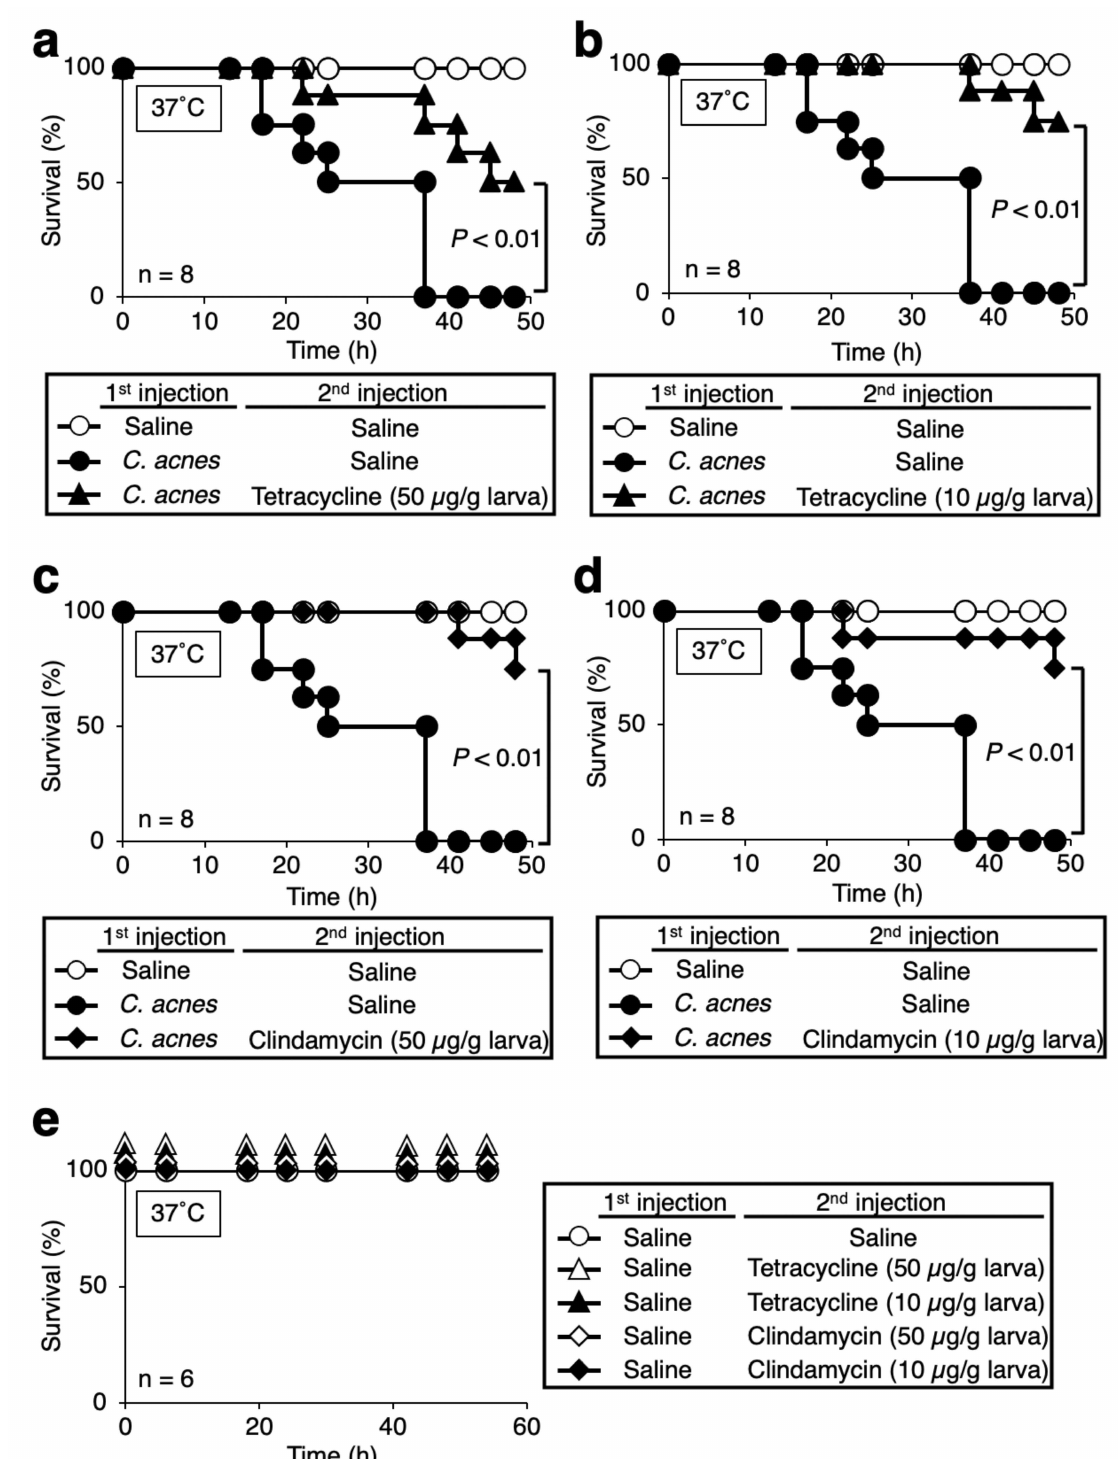
Figure 5. Effect of antibacterial drugs in silkworms infected by C. acnes. Silkworms were injected with saline (50 µ L) or C. acnes cell suspension (3.6 × 10 8 cells/50 µ L), and then with tetracycline (50 µ g/g larva) ( a ), tetracycline (10 µ g/g larva) ( b ), clindamycin (50 µ g/g larva) ( c ), or clindamycin (10 µ g/g larva) ( d ). The number of surviving silkworms under incubation at 37 ◦ C was measured for 48 h. Statistically significant differences between groups were evaluated using a log-rank test. n = 8/group. ( e ) Silkworms were injected with saline (50 µ L), and then with tetracycline (50 µ g/g larva), tetracycline (10 µ g/g larva), clindamycin (50 µ g/g larva), or clindamycin (10 µ g/g larva). The number of surviving silkworms under incubation at 37 ◦ C was measured for 54 h. n =